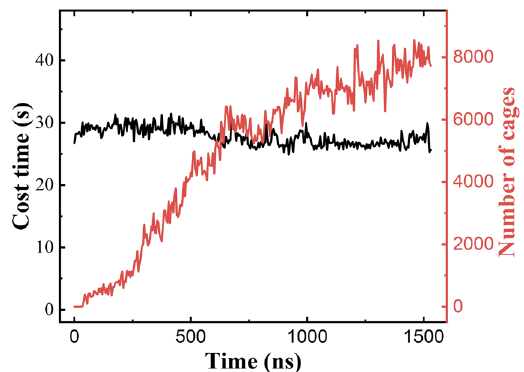
Figure 7: Cost time ( black ) and number of cages ( red ) by HTR algo - rithm along with the simulation time of clathrate hydrate nucleation.